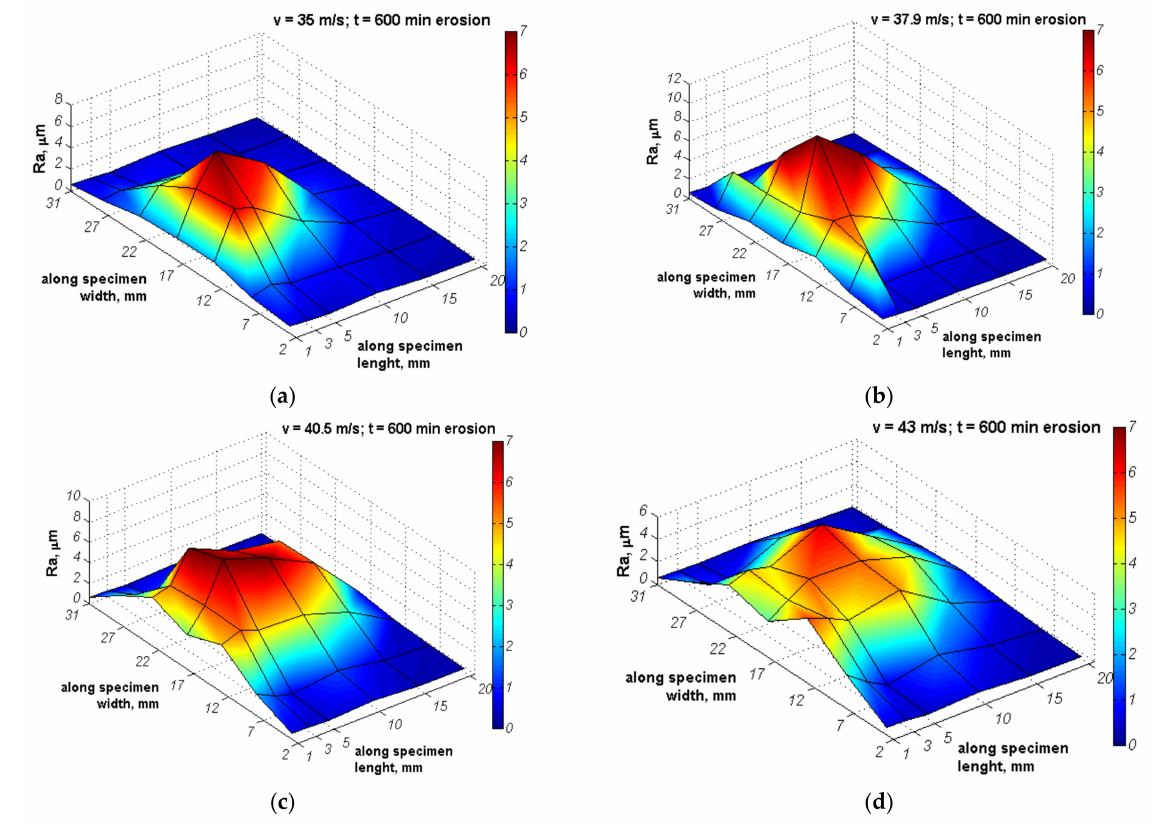
Figure 13. Distribution of the Ra parameter on the surface of the S235JR-TT steel tested for resistance to cavitation erosion at a flow velocity of ( a ) 35 m/s, ( b ) 37.9 m/s, ( c ) 40.5 m/s and ( d ) 43 m/s.